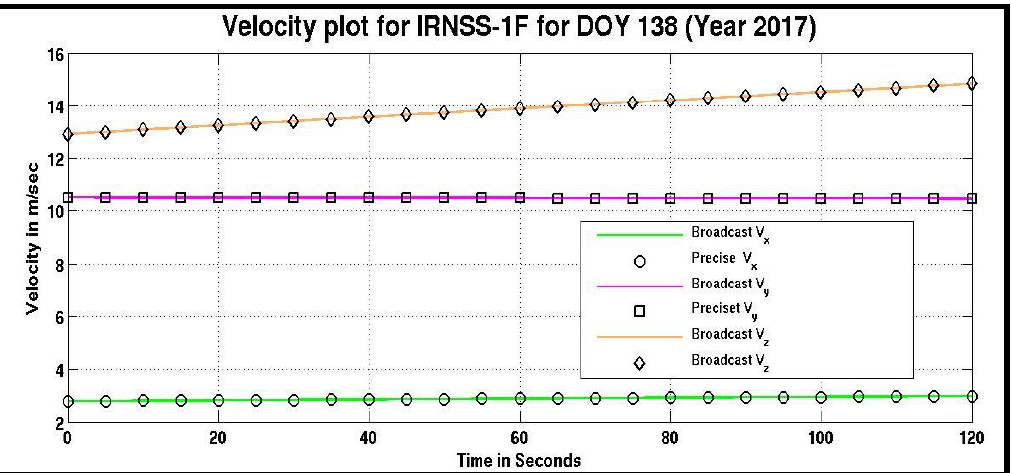
Fig. 3. Velocity comparison of IRNSS-1F for DOY 138 (Year 2017): Precise vs Broadcast